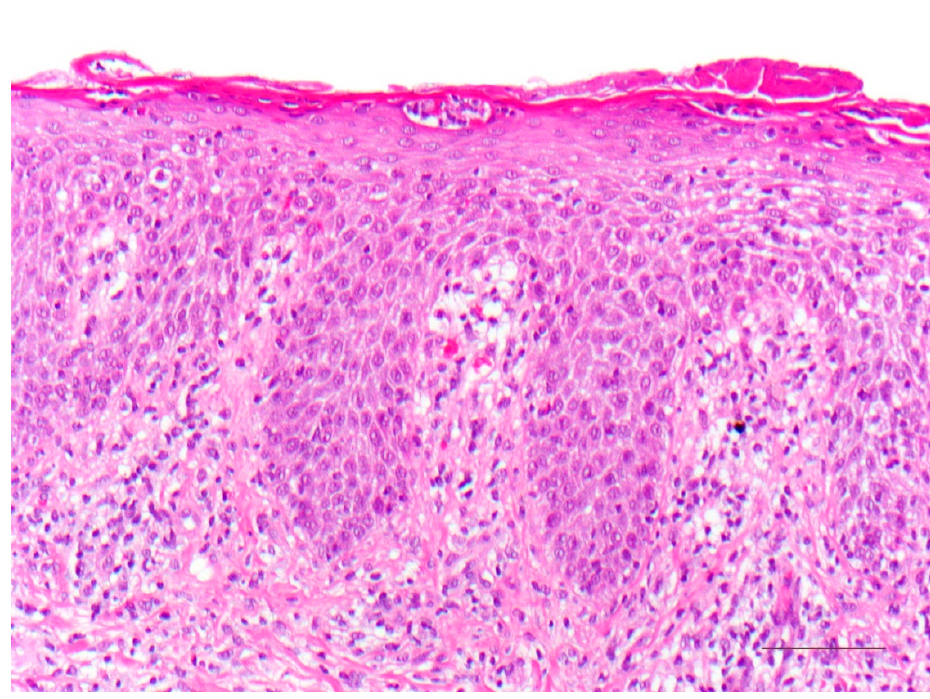
Figure 13. SAM syndrome. Psoriasiform dermatitis with dilated intercellular spaces of the epidermis without blistering (“desmosomal acantholysis”). HE stain, bar = 100 µm.